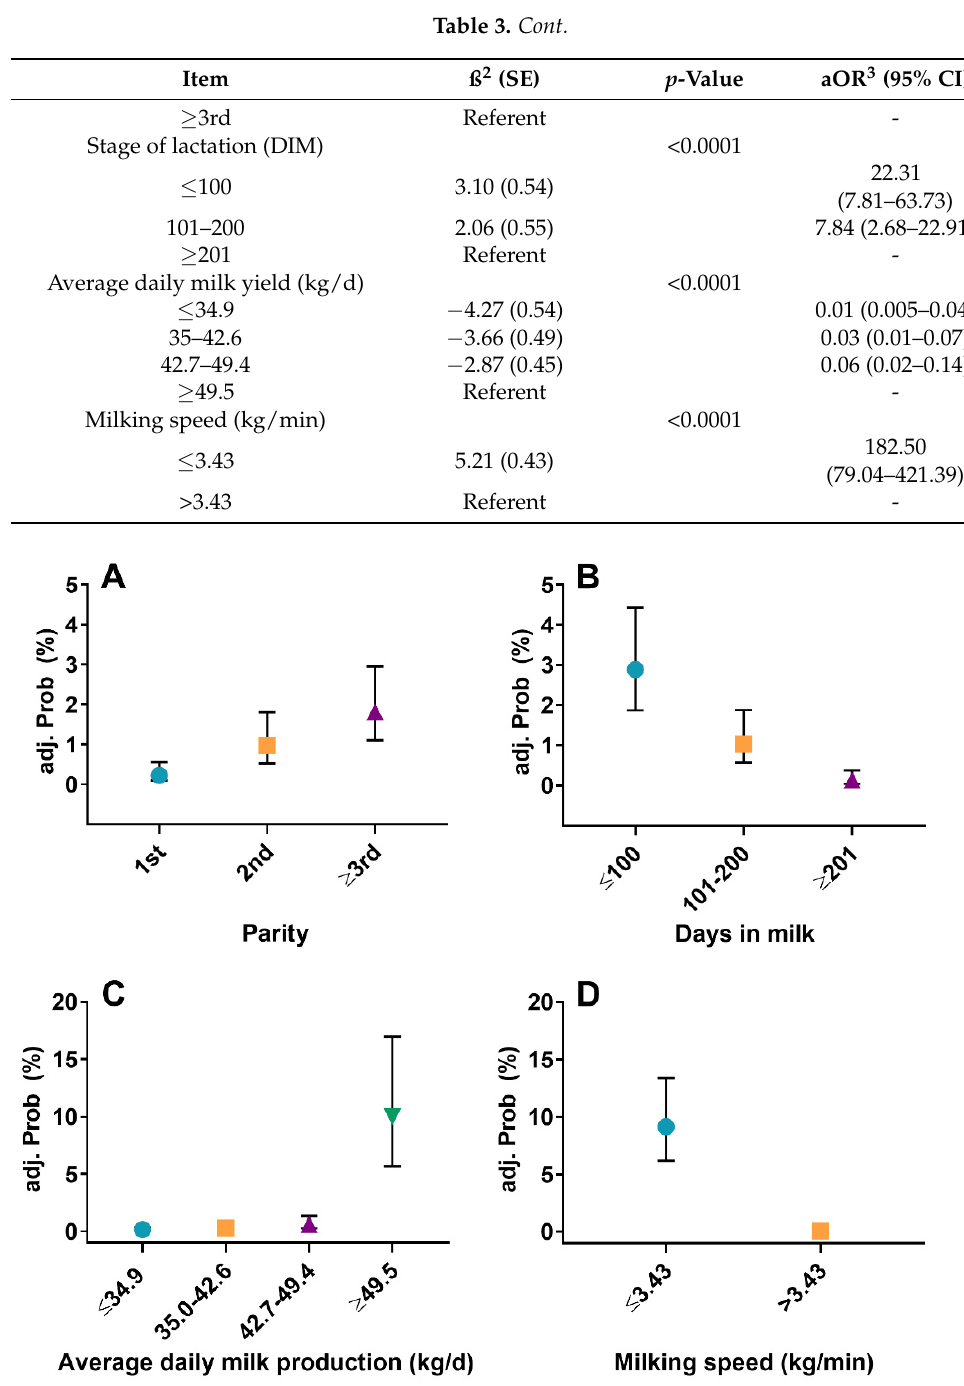
Figure 1. Adjusted probabilities (95% confidence intervals) of repeated forced take-off at the end of machine milking for cows with different parity (A) , stage of lactation (B) , average daily milk pro- duction (C) , and milking speed (D) . C and D : error bars partially